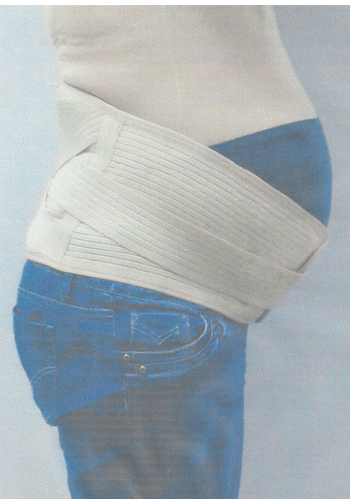
Figure 4: Variteks Ortopedi Sanayi belt Source: Cakmak, Inanir [19] Image by: Cakmak, Inanir [19].